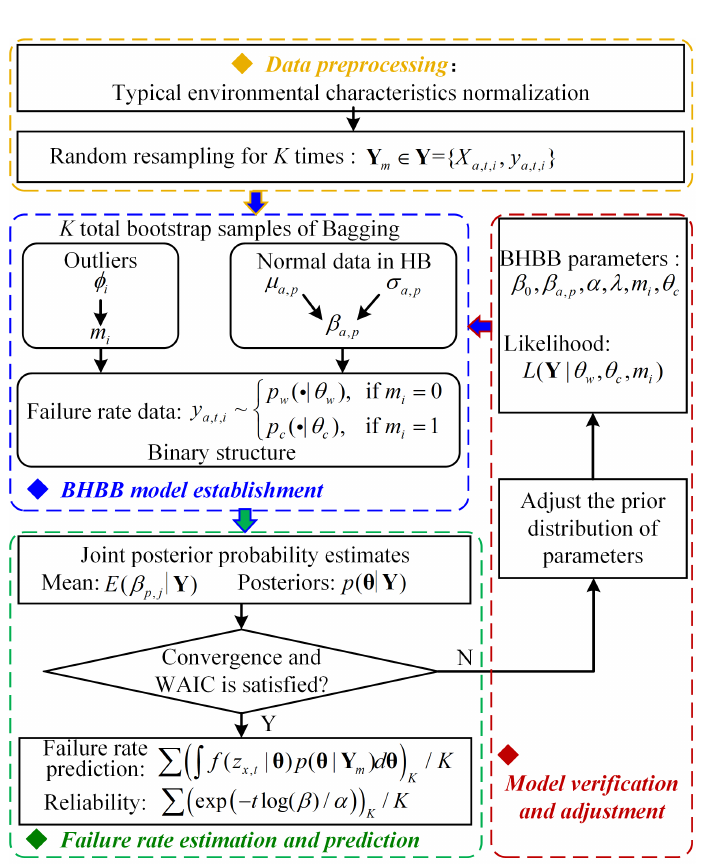
Figure 4. The BHBB framework for failure evaluation of